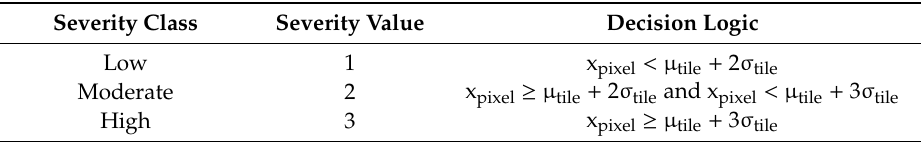
Table 2. Decision logic for labeling the low, moderate, and high severity classes when severity was not assigned by the BAER, RAVG, or MTBS reference datasets. Values for each pixel dNBR value (x pixel ) was assigned by comparing it to the LANDFIRE tile-wide mean ( µ tile ) and standard deviation ( σ tile ) dNBR